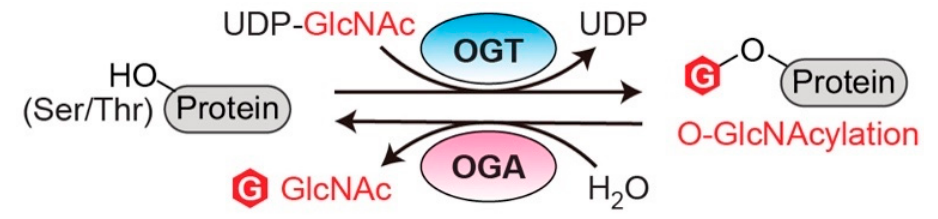
Figure 1. O-GlcNAc cycling enzymes (OGT and OGA) catalyze the reversible protein O-GlcNAcylation. OGT: O-GlcNAc transferase. OGA: O-GlcNAcase. UDP-GlcNAc: uridine diphosphate N -acetylglucosamine.